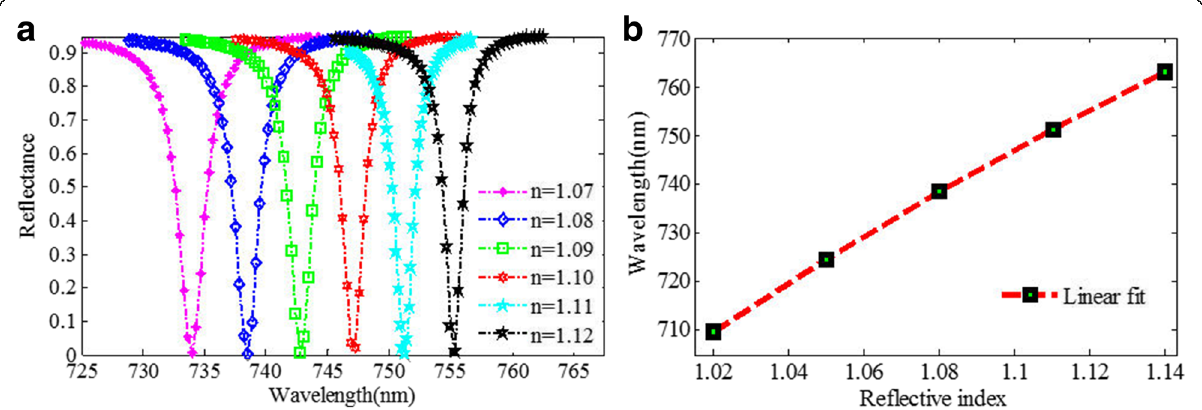
Fig. 10 a Reflection spectra of the plasmonic refractive index sensor with various refractive index of the environment. b Resonant wavelength shift against the surrounding refractive index